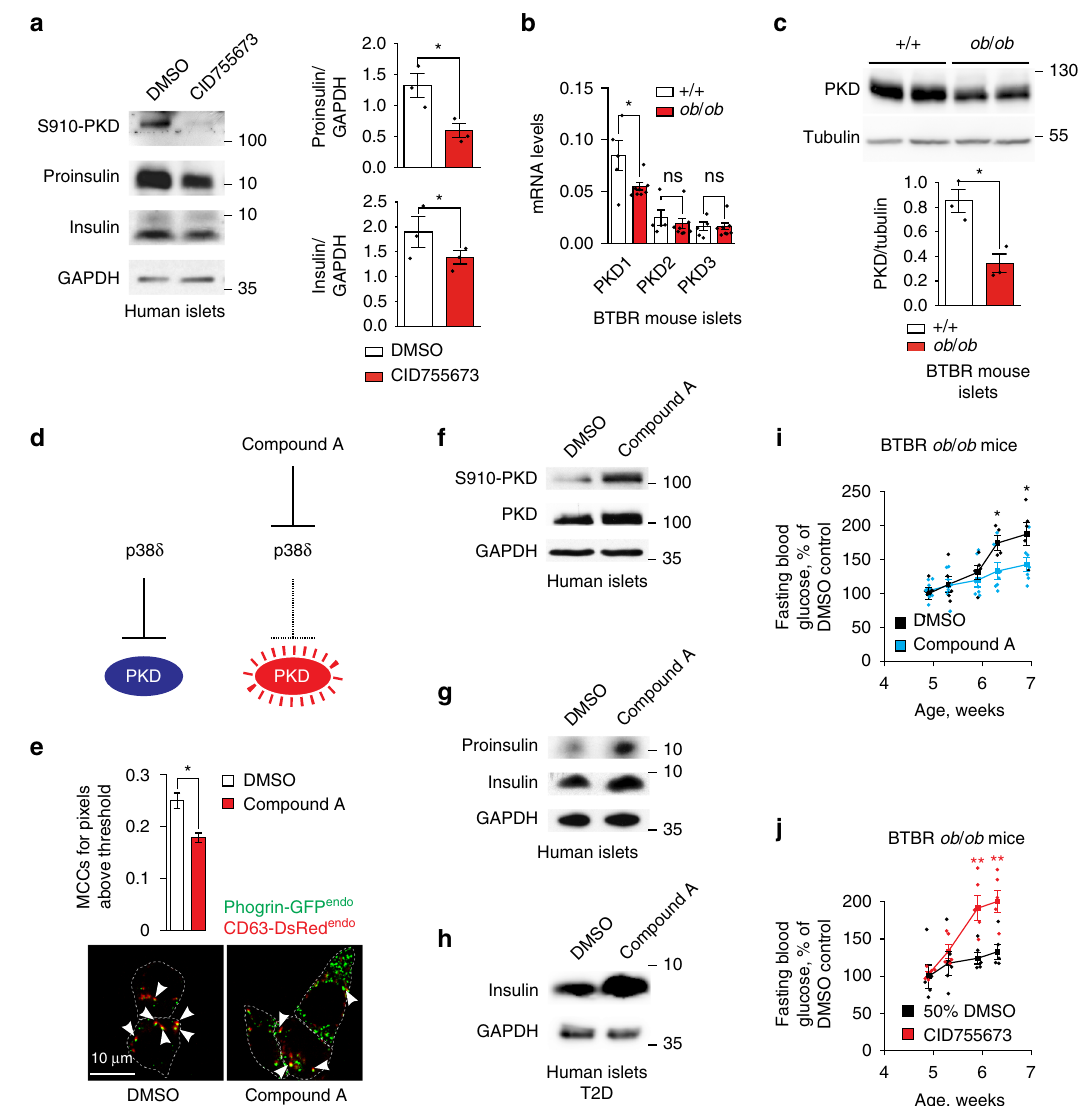
Fig. 4 SINGD contributes to β cell dysfunction in diabetes. a Immunoblot of indicated proteins using lysates of isolated human islets treated with DMSO or PKD inhibitor CID755673 (30 μ M) for 24 h. GAPDH was used as a loading control. Quanti fi cation of Proinsulin/GAPDH and Insulin/GAPDH ratios, * P < 0.05, N = 3, one-tailed, paired t -test. b Quantitative RT-PCR using mRNA isolated from pancreatic islets of 8-week-old BTBR + / + and BTBR ob / ob mice using primer pairs amplifying cDNA of PKD1, PKD2 and PKD3. The expression values were normalized to housekeeping genes HPRT and GAPDH. N + / + = 8; N ob / ob = 5; * P < 0.05, two-tailed t -test. c Immunoblot of PKD using lysates of islets isolated from 8-week-old BTBR + / + and BTBR ob / ob mice.